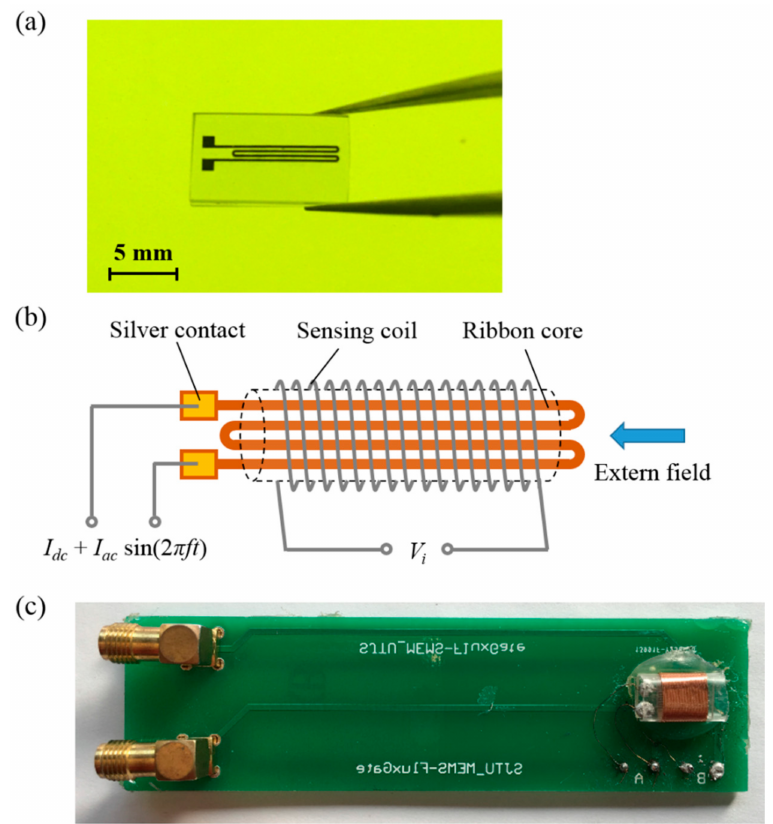
Figure 3. ( a ) Photograph of four-strip meander-core sample. ( b ) Schematic diagram of orthogonal fluxgate sensor head structure. ( c ) Photograph of orthogonal fluxgate sensor head with winding sensing